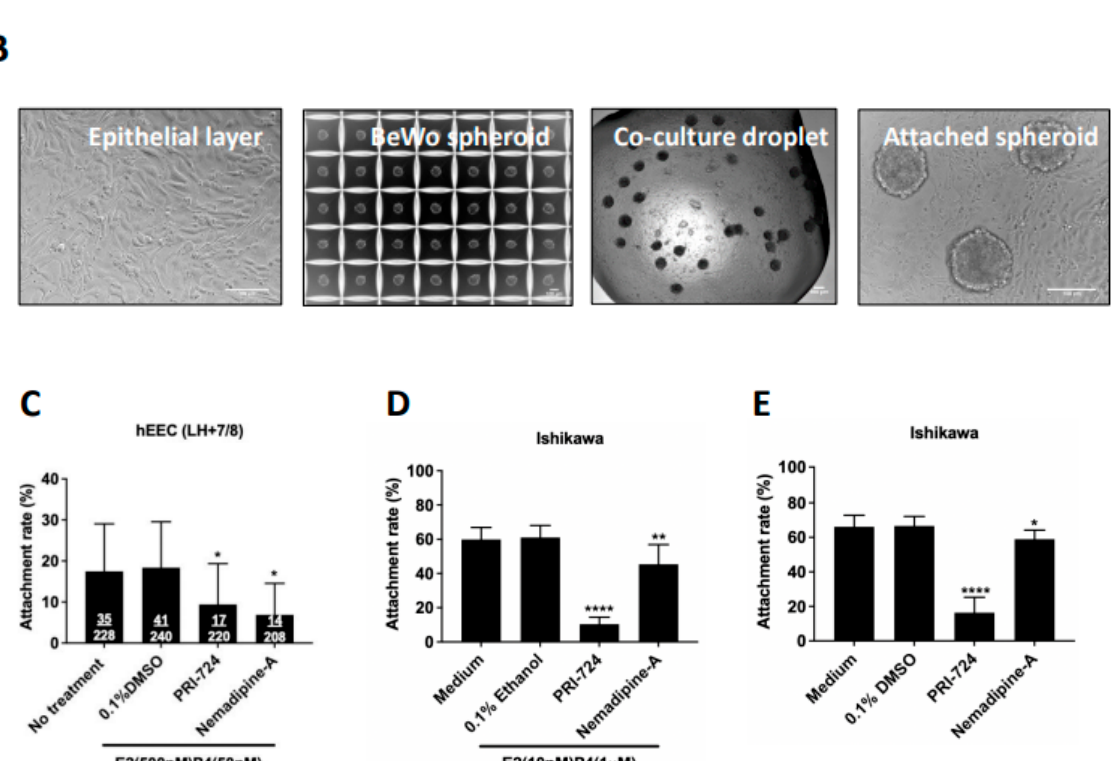
Figure 3. The effect of Nemadipine-A on BeWo spheroid attachment on primary human endometrial epithelial cells (hEECs) and Ishikawa cells with or without steroid hormone treatment. ( A ) The purity of the isolated primary hEECs and hESCs were determined by cytokeratin (epithelial cell marker, green) and vimentin (stromal cell marker, green) staining, respectively. More than 85% of the hEECs were positive for cytokeratin, and more than 90% of the isolated hESCs were positive for vimentin. All cells were counter-stained with DAPI (nucleus staining, blue). ( B ) Representative mi- crographs of the isolated primary hEEC monolayer, BeWo spheroids generated in AggreWell, co-